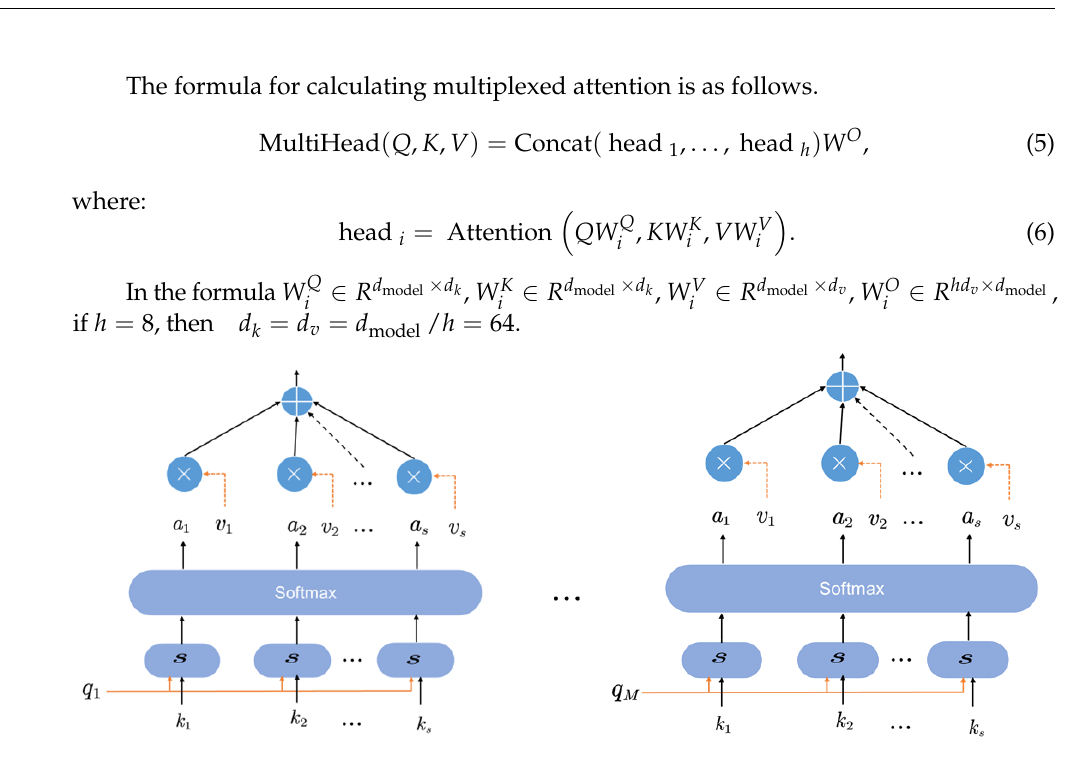
Figure 5. Multi-way attention schematic.